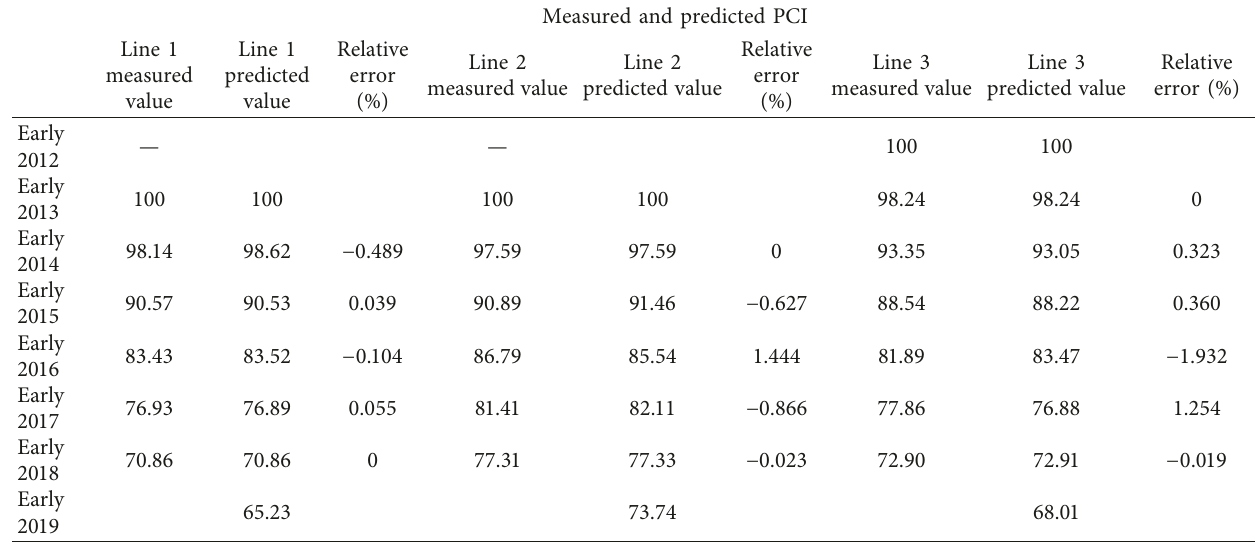
Table 11: Measured and predicted PCI for three typical roads of the trunk highway in Hunan Province. Measured and predicted PCI